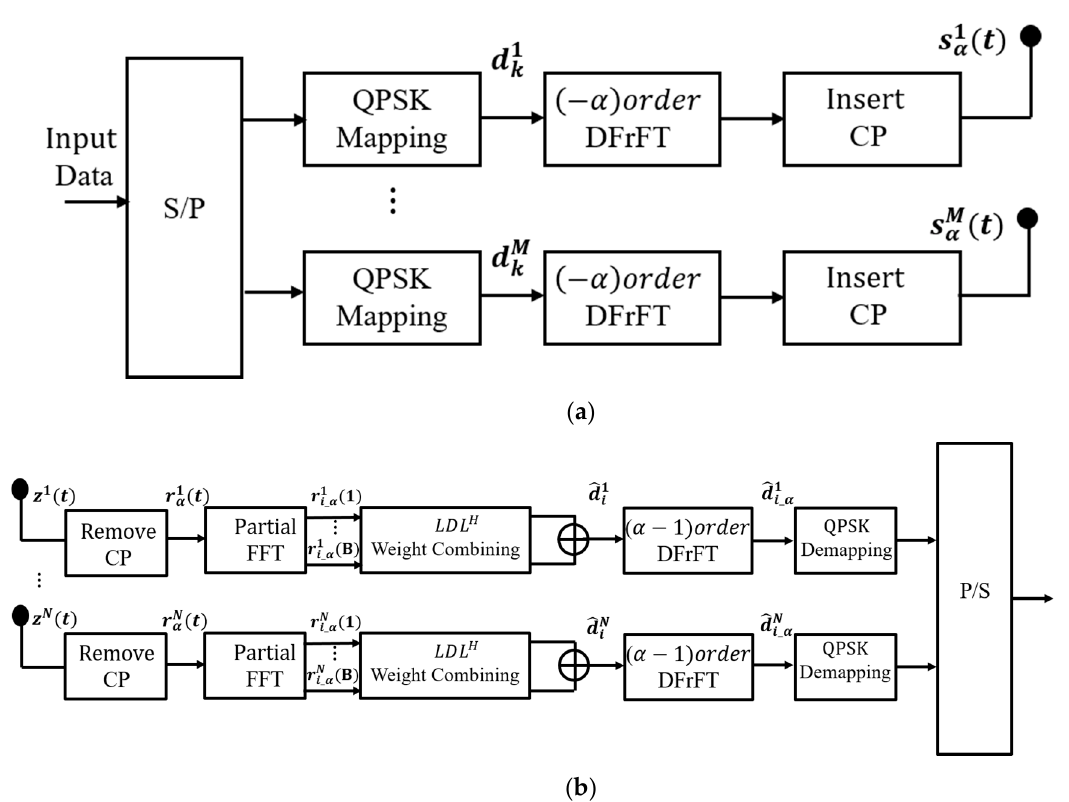
Figure 1. ( a ) Diagram of transmitter of PFrFT ‐ OFDM with 𝐋𝐃𝐋 𝐇 iterative weight combining in MIMO scenario; ( b ) diagram of receiver of PFrFT ‐ OFDM with 𝐋𝐃𝐋 𝐇 iterative weight combining in MIMO scenario.